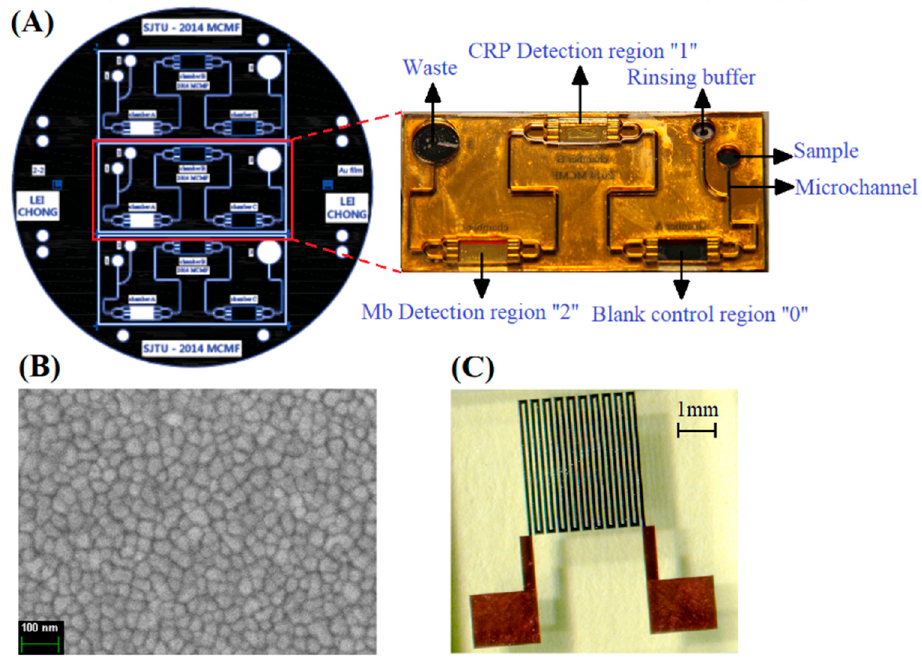
Figure 1. ( A ) The designed diagram of the microfluidic device, and the inset showing the photograph of the fabricated microfluidic device. ( B ) The Scanning Electron Microscopy image of the thin gold film. ( C ) The fabricated multilayer MI element.